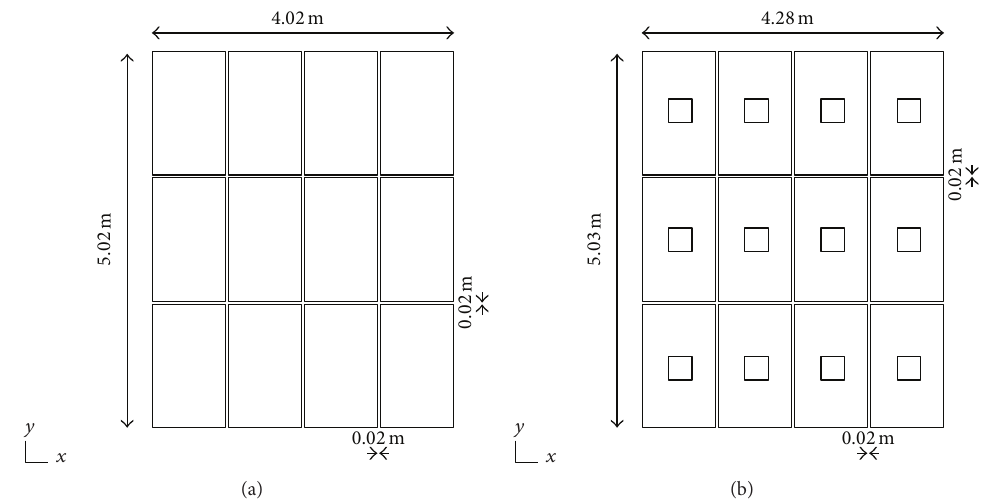
Figure 2: (a) Arrayed set of conventional solar panels 4.02 × 5.02 m × m with gaps and (b) arrayed set of holes with solar panels 4.28 × 5.03 m × m with gaps. Panel types expose to the wind the same surface area.